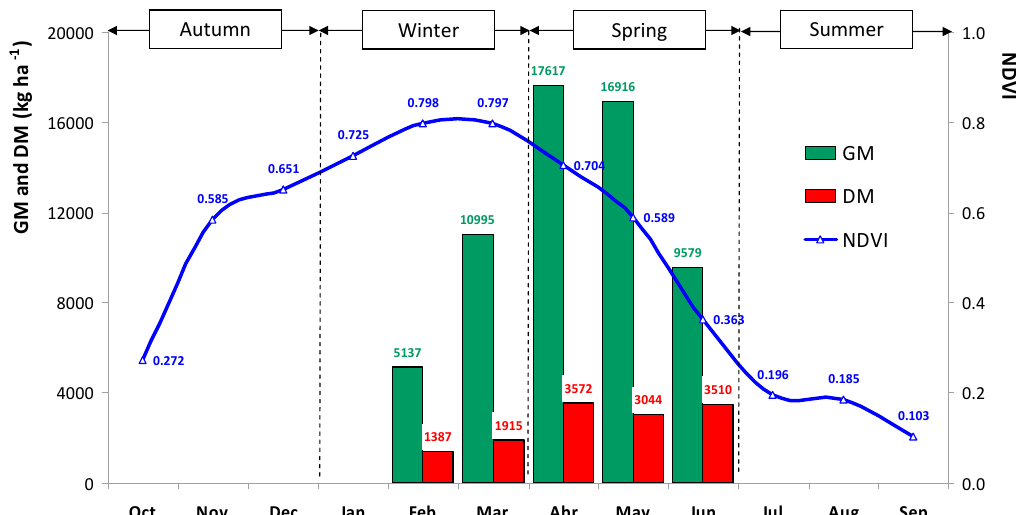
Figure 1. Evolution pattern over the year of normalized difference vegetation index (NDVI), of green matter (GM) and dry matter (DM) of a pasture in Mitra farm, Alentejo, mean of three years,